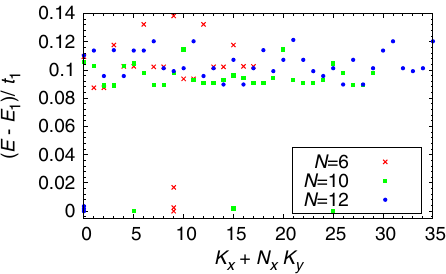
FIG. 1. Low-energy spectrum for N ¼ 6 , 10, and 12, N x ¼ 6 . The energies are shifted by E N= 2 , N y ¼ 1 , the lowest energy for each system size. We only show the lowest energy per momentum sectors in addition to the 3-fold ground state. We note the good ground-state degeneracy, even for relatively small system sizes such as 6